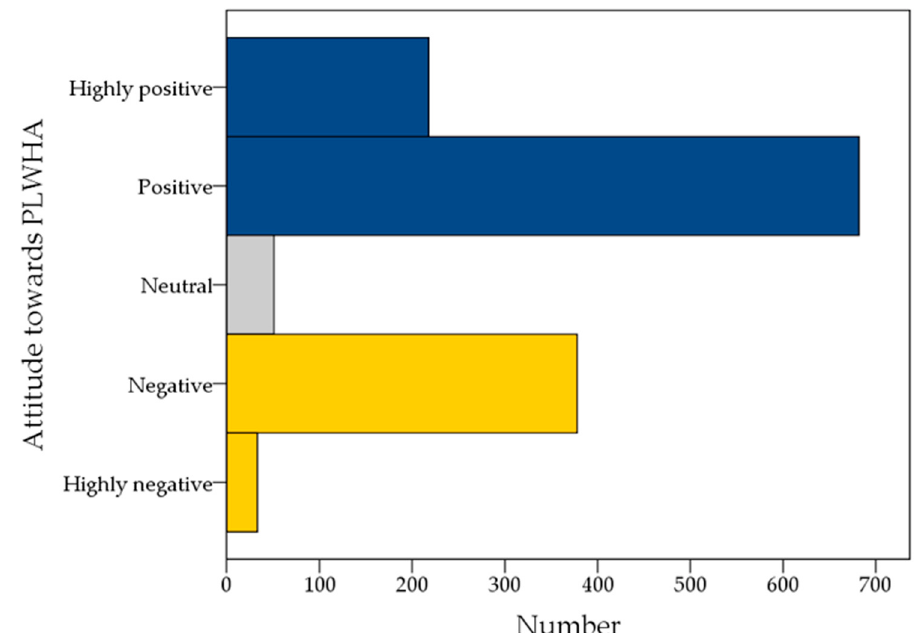
Figure 2. The overall attitude of the study respondents towards people living with HIV/AIDS (PLWHA) based on HIV stigma scale. An HIV-stigma score of +30 to +16 indicated highly positive attitude, +15 to +1 indicated positive attitude, a score of zero indicated a neutral attitude, − 1 to − 15 indicated a negative attitude, and − 16 to − 30 indicated an overall highly negative attitude. HIV: Human immunodeficiency virus; AIDS: Acquired immunodeficiency syndrome. Table 3. Results of multinomial regression analysis of factors associated with a positive attitude towards PLWHA among the study